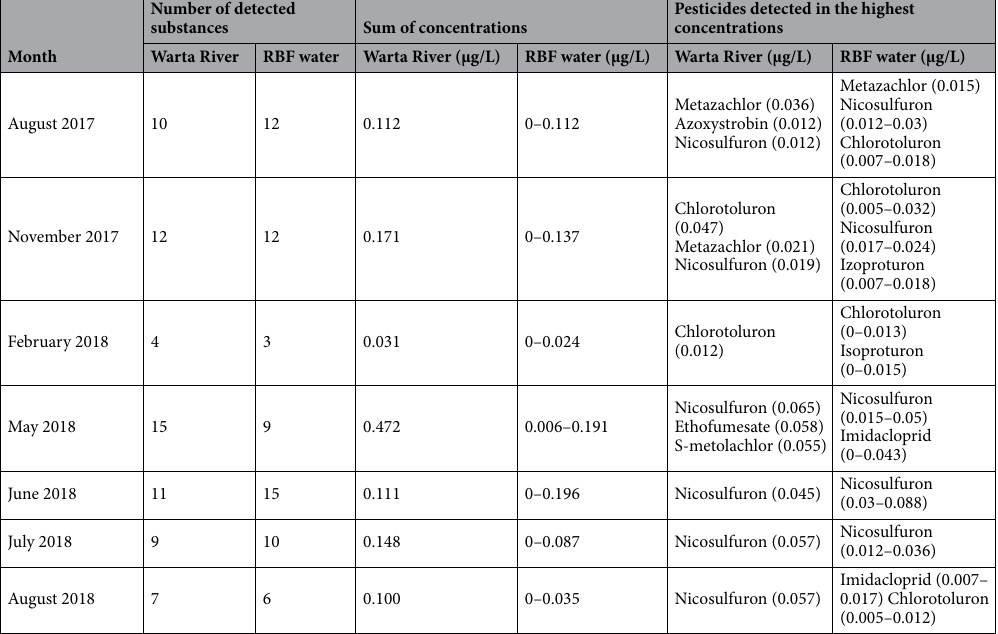
Table 4. Pesticides in river and RBF